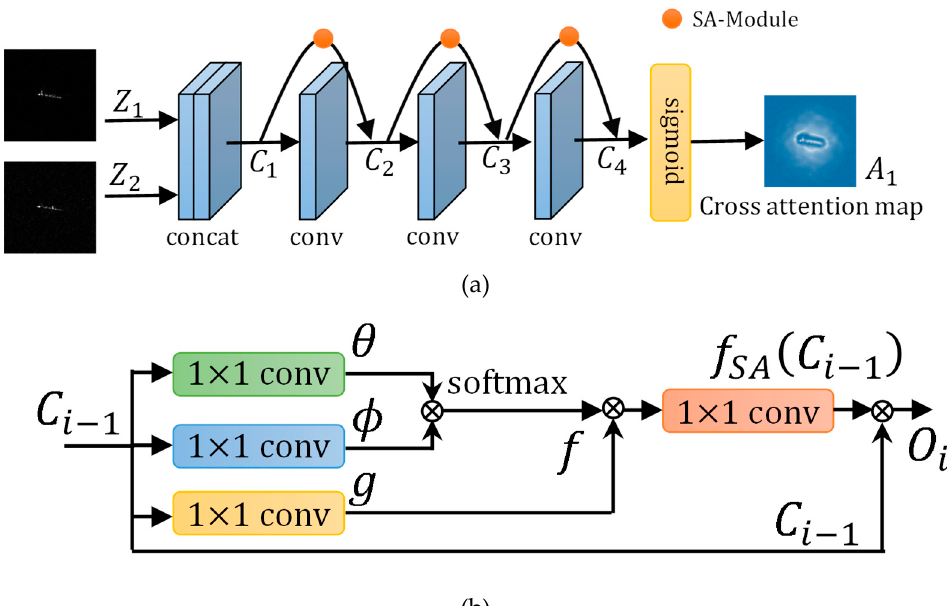
Figure 2. Implementation of the cross-attention subnetwork. ( a ) Cross-attention subnetwork. ( b ) SA- module.